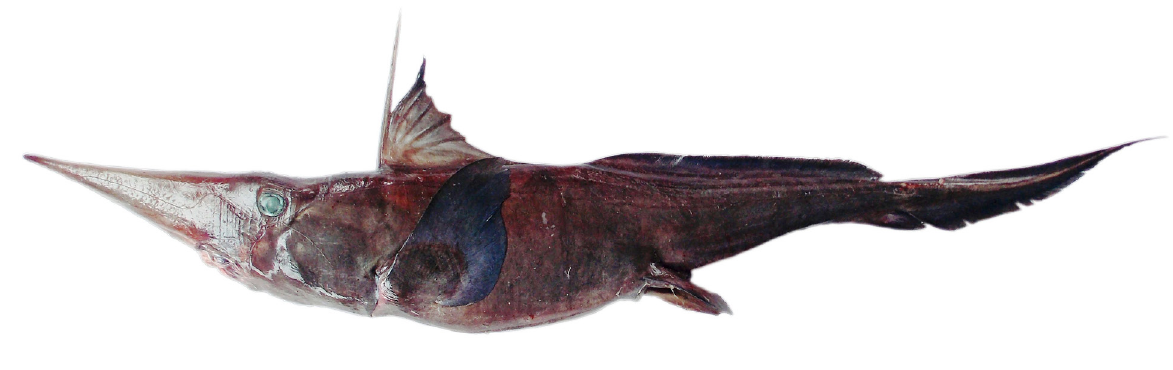
Fig. 7. Dorsal-lateral view of Neoharriotta pinnata from Andaman